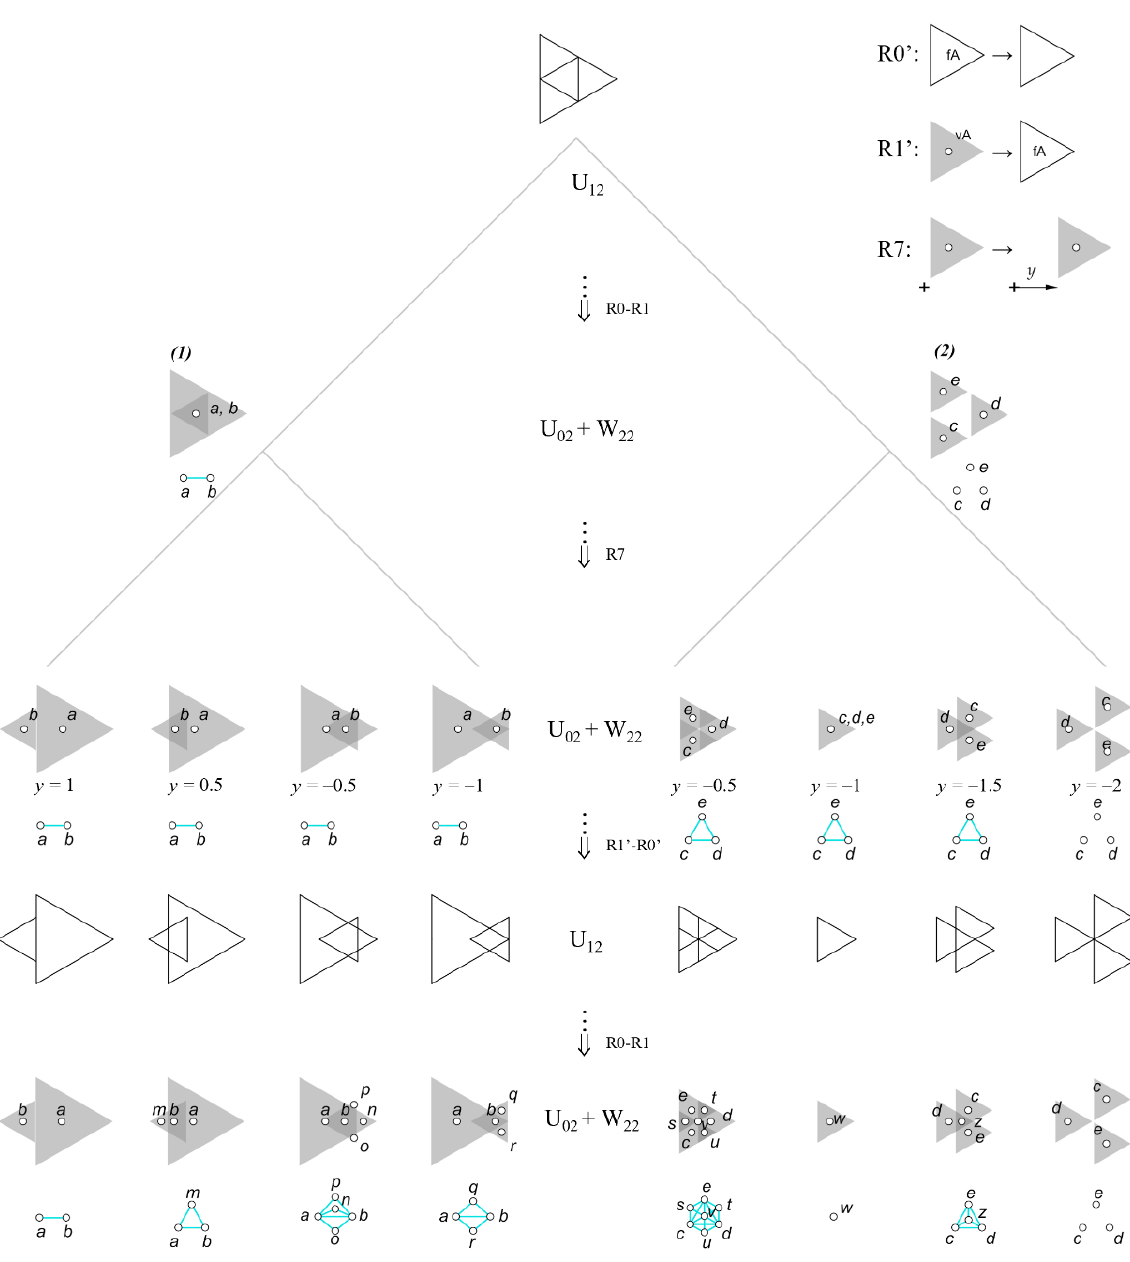
Figure 3. Comparison between graphs derived from discrete shape transformation (middle) and embedding on continuous shapes (bottom). The description indicates their operating algebras.